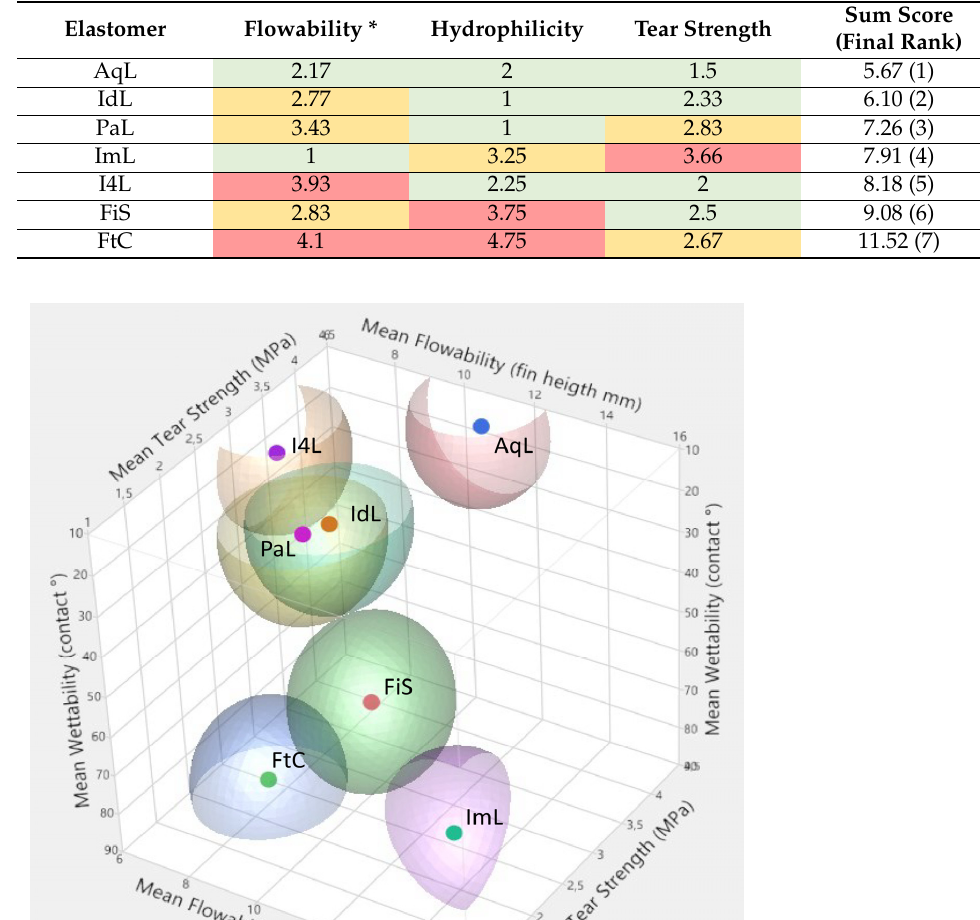
Table 7. Light-body materials rankings from the three experiments, sorted by the final rank (sum score). Green, yellow, and red indicate a score classification of ≤ 2.5, ≤ 3.5, and >3.5. * The flowability rank derives from the sum of the mean rank values from light-body materials and the mixed test set up divided by 2.